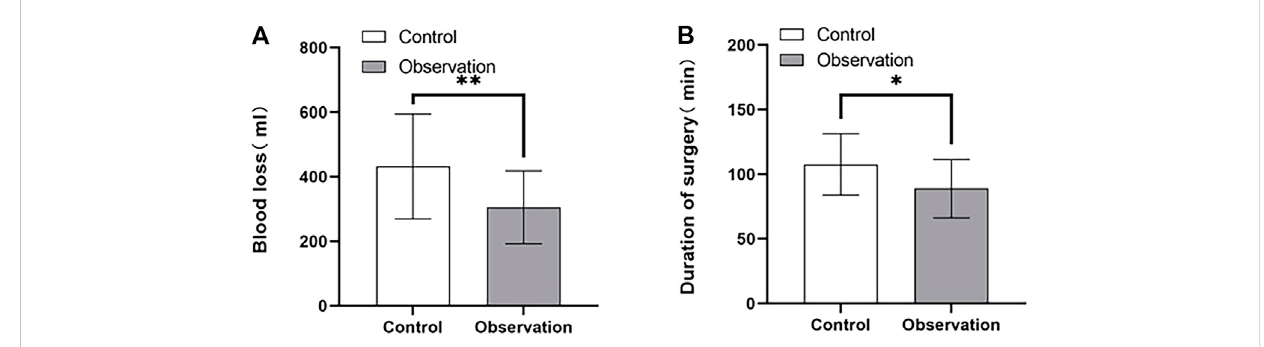
Comparison of intraoperative bleeding (A) and operative time (B) between control and observation groups.* p < 0.05, ** p < 0.01.